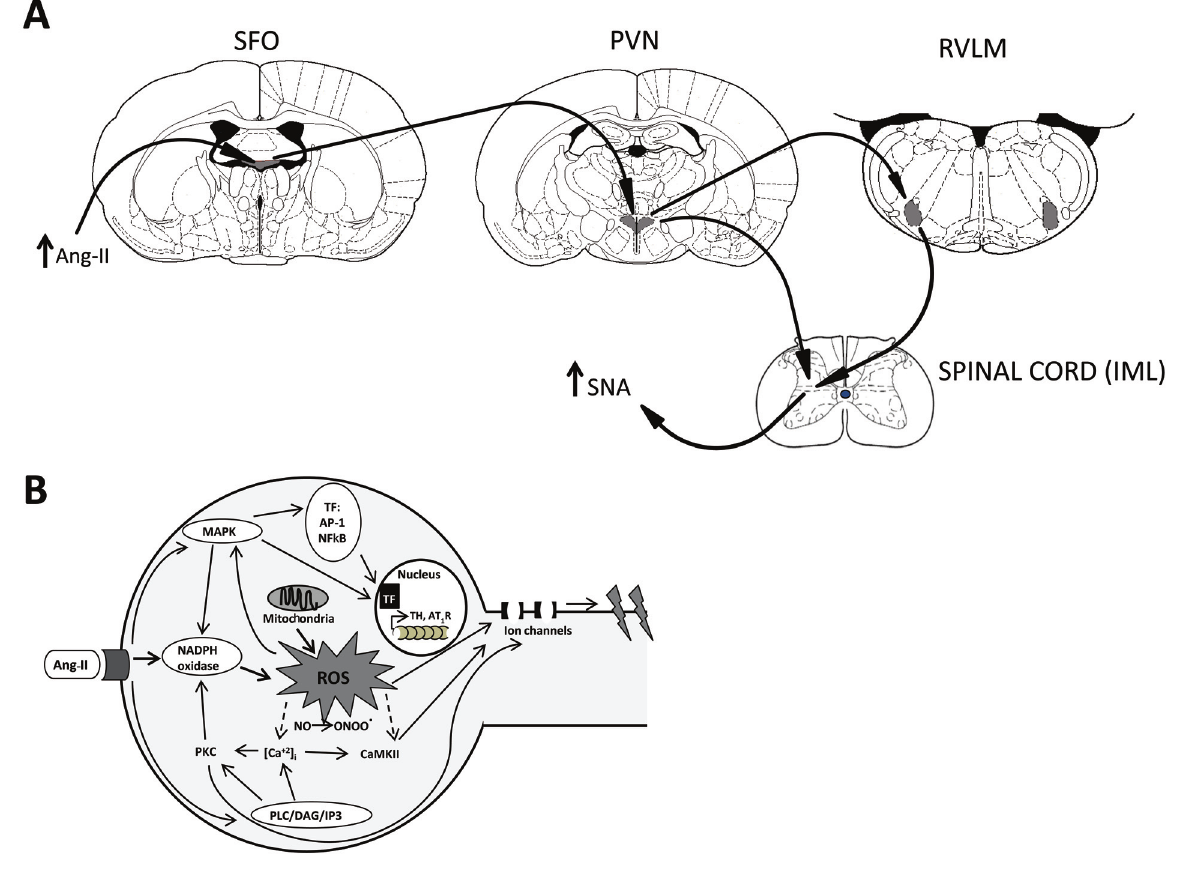
Figure 1. A , The SFO-PVN-RVLM pathway. Diagram showing four coronal sections where the subfornical organ (SFO), the paraven- tricular nucleus of the hypothalamus (PVN), and the rostral ventrolateral medulla (RVLM) have been highlighted in gray. Note that both PVN and RVLM neurons project to the intermediolateral column (IML) of the spinal cord. B , Mechanisms involving angiotensin-II (Ang- II)-induced reactive oxygen species (ROS) that affect neuronal firing. Of note, the SFO neurons are affected by both blood-borne and brain-borne Ang-II (local production within the SFO) while the PVN and RVLM neurons are affected only by the brain-borne Ang-II. B , Ang-II binds to its AT1 receptor (AT 1 R) resulting in activation of NADPH oxidase, which in turn increases ROS within the neuron. The in- crease in ROS converts the intracellular nitric oxide to peroxynitrite. Ang-II also activates the mitogen-activated protein kinase (MAPK) and the PLC/DAG/IP3 pathway. ROS can directly activate the MAPK, which increases the NADPH oxidase activity leading to more ROS. MAPK also activates nuclear transcriptional factors (NF) such as AP-1 and NFκB, which modulate the expression of tyrosine hydroxylase (TH) and AT1 receptors. The PLC/DAG/IP3 pathway activates protein kinase (PKC), contributing to the activation of NAPH oxidase. Moreover, the PLC/DAG/IP3 pathway increases the intracellular calcium concentration resulting in activation of the CaMKII complex. Finally, PKC, CaMKII, and ROS act on ion channels in the cell membrane changing neuronal firing. PLC = phospholipase C; DAG = diacylglycerol; IP3 = inositol 1,4,5-trisphosphate; AP-1 = activator protein 1; NFκB = nuclear factor kappa-light-chain-enhancer of activated B cells; CaMKII = calcium/calmodulin-dependent protein kinase